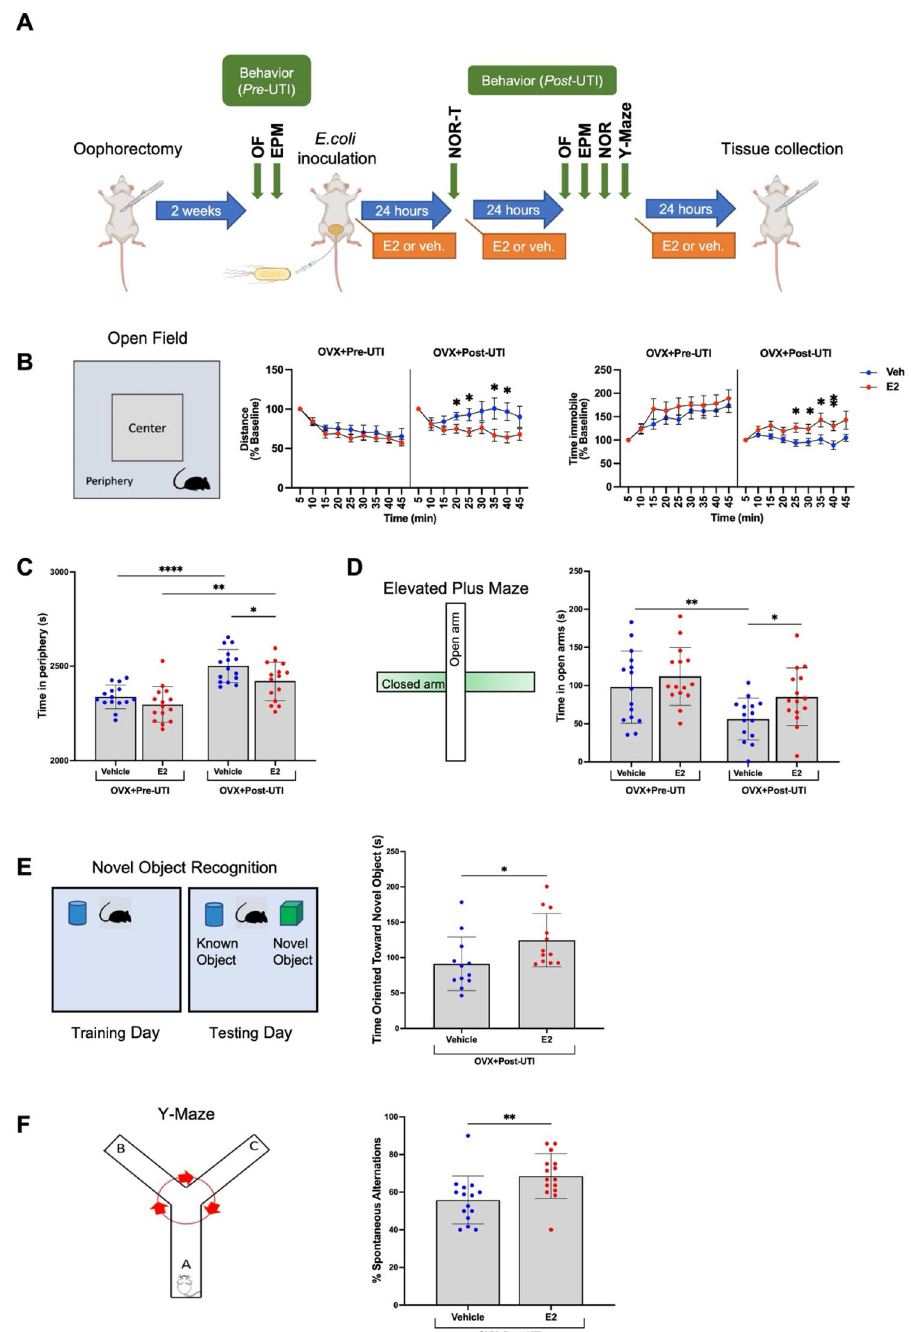
Figure 2. 17β-estradiol (E2) significantly ameliorates UTI-induced delirium-like behavior. ( A ) Schematic of primary experimental design and treatment schedule of E2. Note that to prevent any habituation, novel object recognition (NOR) and Y-maze behavioral tests were only utilized post UTI induction and E2 (or vehicle) treatment. At a given time point behavioral tests were performed sequentially. NOR-T represents training the training phase of the behavioral test. ( B ) Distance (m) and time immobile (sec) as a percent of baseline (initial 5 min). Prior to UTI induction and E2 treatment (OVX + Pre-UTI), there were no treatment effects but a statistically significant effect of time over the course of the 45-min open field test (OF); decreased distance travelled ( F 3,110 = 22.2; p < 0.0001) and increased time spent immobile ( F 5,171 = 14.8; p < 0.0001). Following UTI (OVX + Post-UTI) there was statistically significant time-by-E2 treatment interactions for distance traveled ( F 24,496 = 1.9; p = 0.0052) and time spent immobile ( F 24,448 = 3.0; p < 0.0001). Results of post -hoc tests, comparing treatment effects (vehicle vs. E2) at individual time points, are indicated by asterixis. ( C ) Among oophorectomized and UTI inoculated mice (OVX + Post- UTI), mice treated with E2 spent statistically significantly less time in the periphery of the open field. ( D – F ) Mice (OVX + Post-UTI) treated with E2 spent statistically significantly more time in the open arm (elevated plus maze, EPM), more time and oriented towards a novel object (novel object recognition), and more % spontaneous alterations (Y-maze) compared to the vehicle treated group. Following oophorectomy, but prior to UTI induction and E2 treatment (OVX + Pre-UTI), there were no statistically significant behavioral differences between groups. Group size was n = 15. Data are expressed as mean ± SD. *p < 0.05, **p < 0.01, ****p <